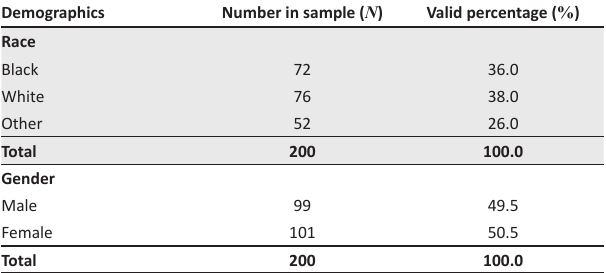
TABLE 3: A socio-demographic profile of respondents based on race and